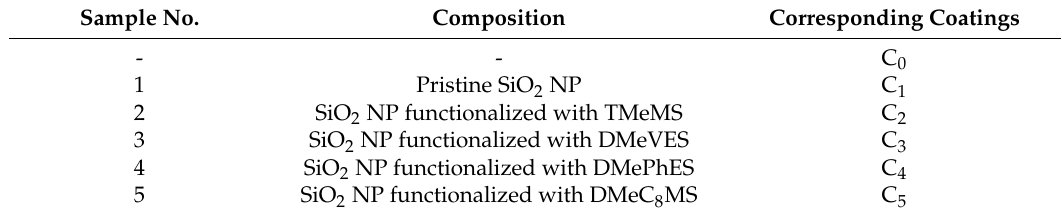
Table 3. Composition of functionalized silica particles and the corresponding coatings. Sample